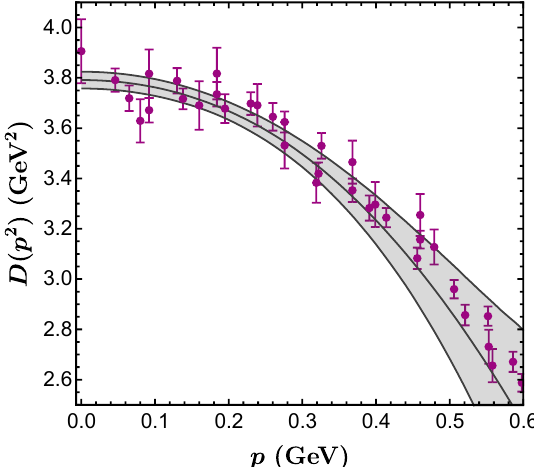
Figure 6 . Landau-gauge gluon-propagator Taylor series (gray) up to fifth order, from the results of table 3. The uncertainty band is the 68% confidence level, assuming a uniform distribution for the Taylor-series coefficients. The lattice data from refs. [9, 39, 40] are shown in